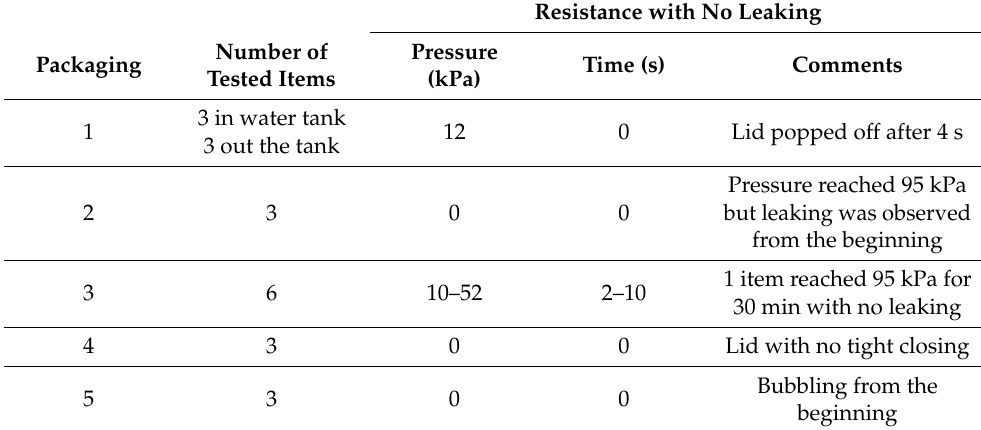
Table 2. Results from the pressure leakproof